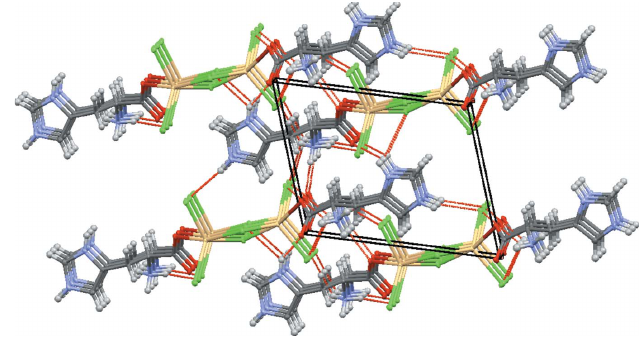
Figure 2 Packing diagram for (I). Red dashed lines indicate hydrogen bonds.